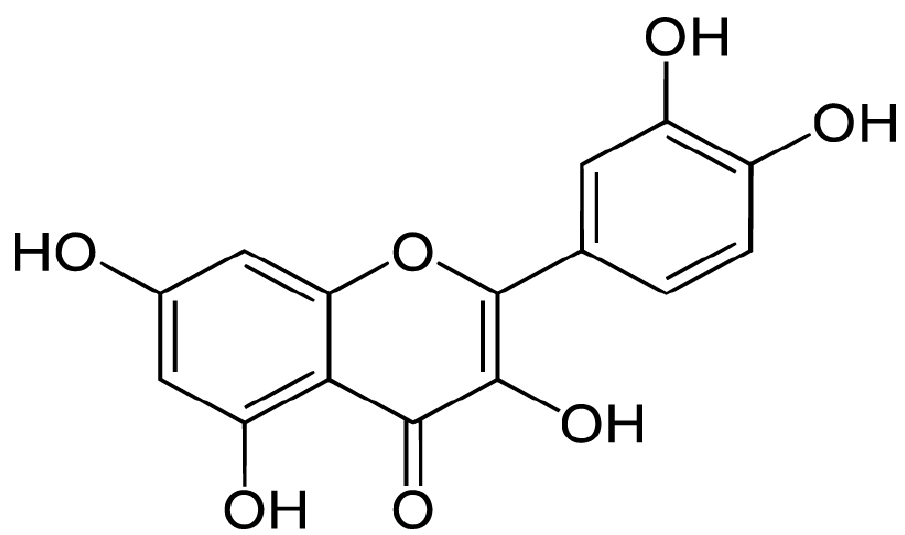
Figure 1. Chemical structure of quercetin.